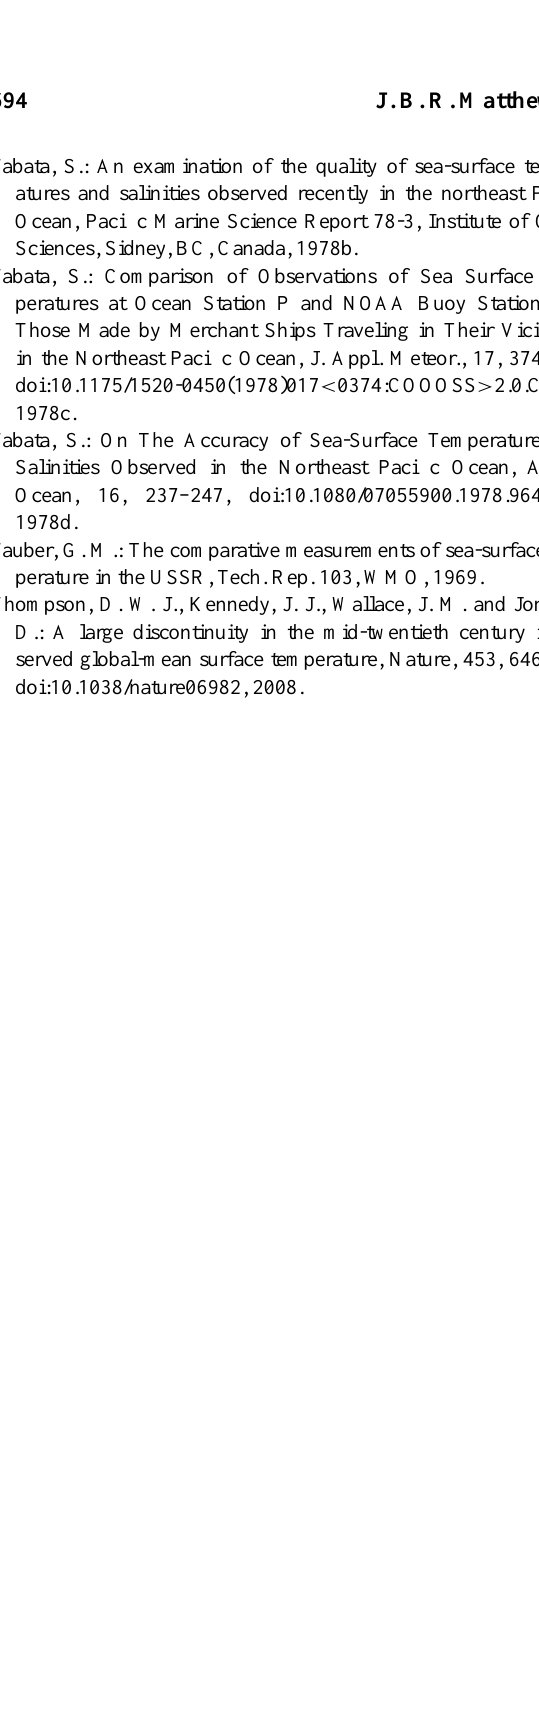
Tabata, S.: An examination of the quality of sea-surface temper- atures and salinities observed recently in the northeast Pacific Ocean, Pacific Marine Science Report 78-3, Institute of Ocean Sciences, Sidney, BC, Canada, 1978b. Tabata, S.: Comparison of Observations of Sea Surface Tem- peratures at Ocean Station P and NOAA Buoy Stations and Those Made by Merchant Ships Traveling in Their Vicinities, in the Northeast Pacific Ocean, J. Appl. Meteor., 17, 374–385,